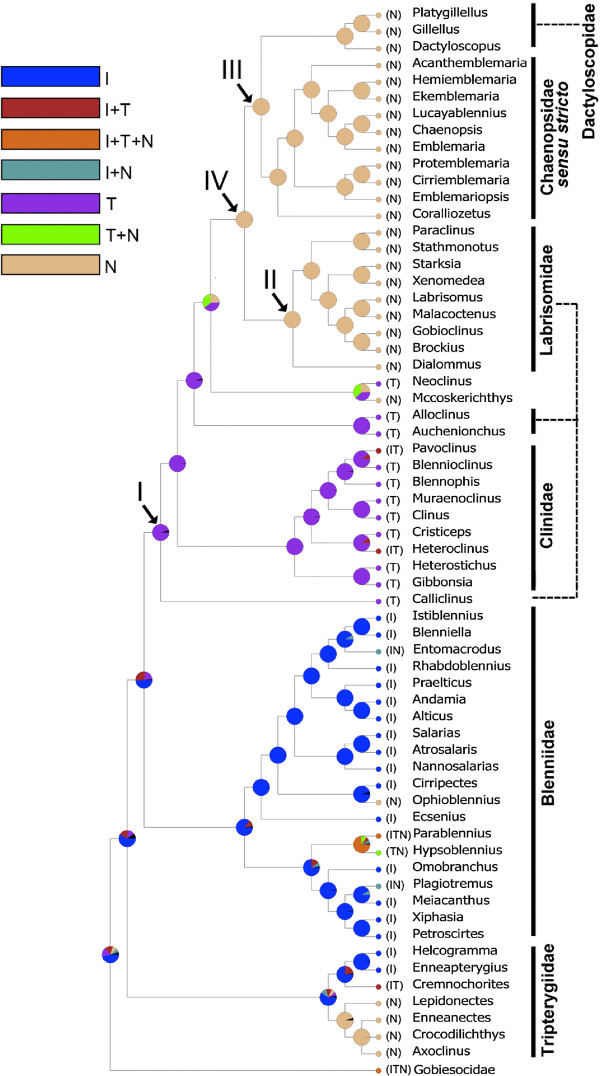
Inferred ancestral distribution at each node of the blenniiform phylogeny estimated by BBM analysis implemented in RASP. Pie charts at each node indicate probabilities of alternative ancestral distributions. I: tropical IndoPacific, T: temperate, N: Neotropics.